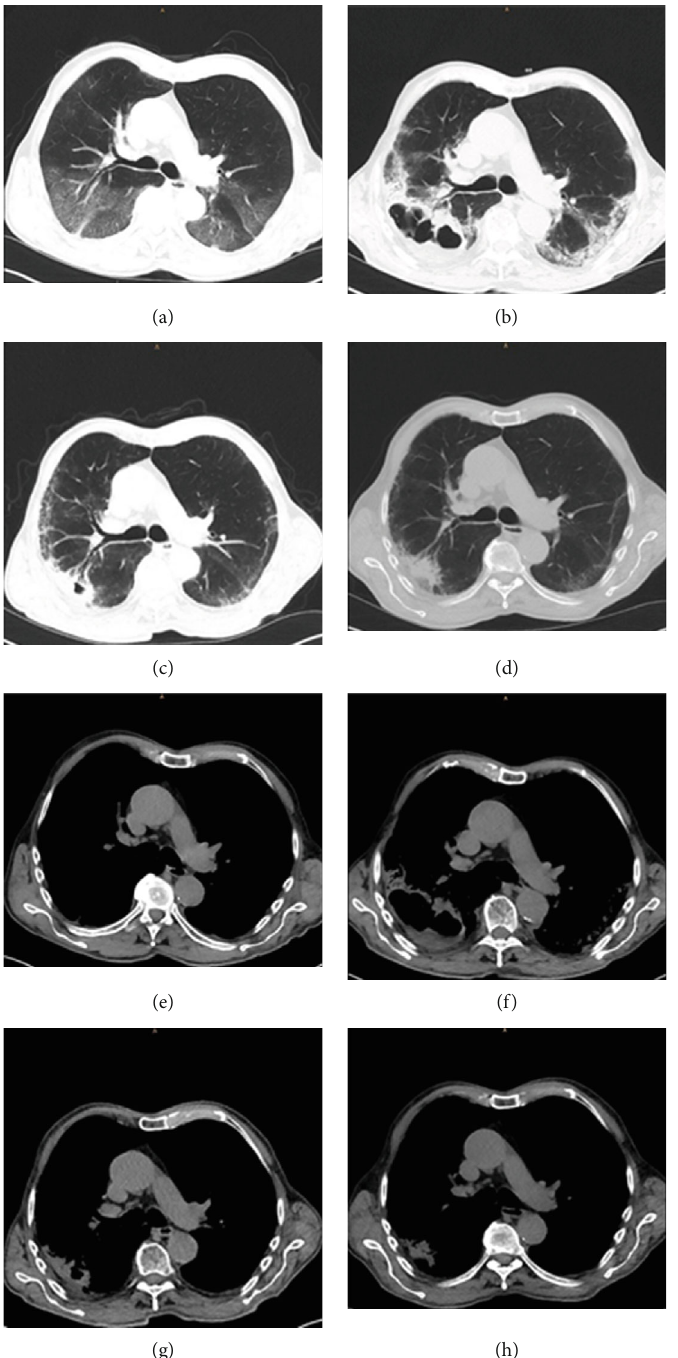
Figure 1: Axial chest CT scans showing peripheral ground-glass opacities of both lungs at hospital admission (a, e), a large cavitary lesion at the right inferior lung lobe at the end of corticosteroid treatment (b, f), a declining cavitary lesion at the end of antibacterial therapy (c, g), and a small consolidation at two-month follow-up (d,